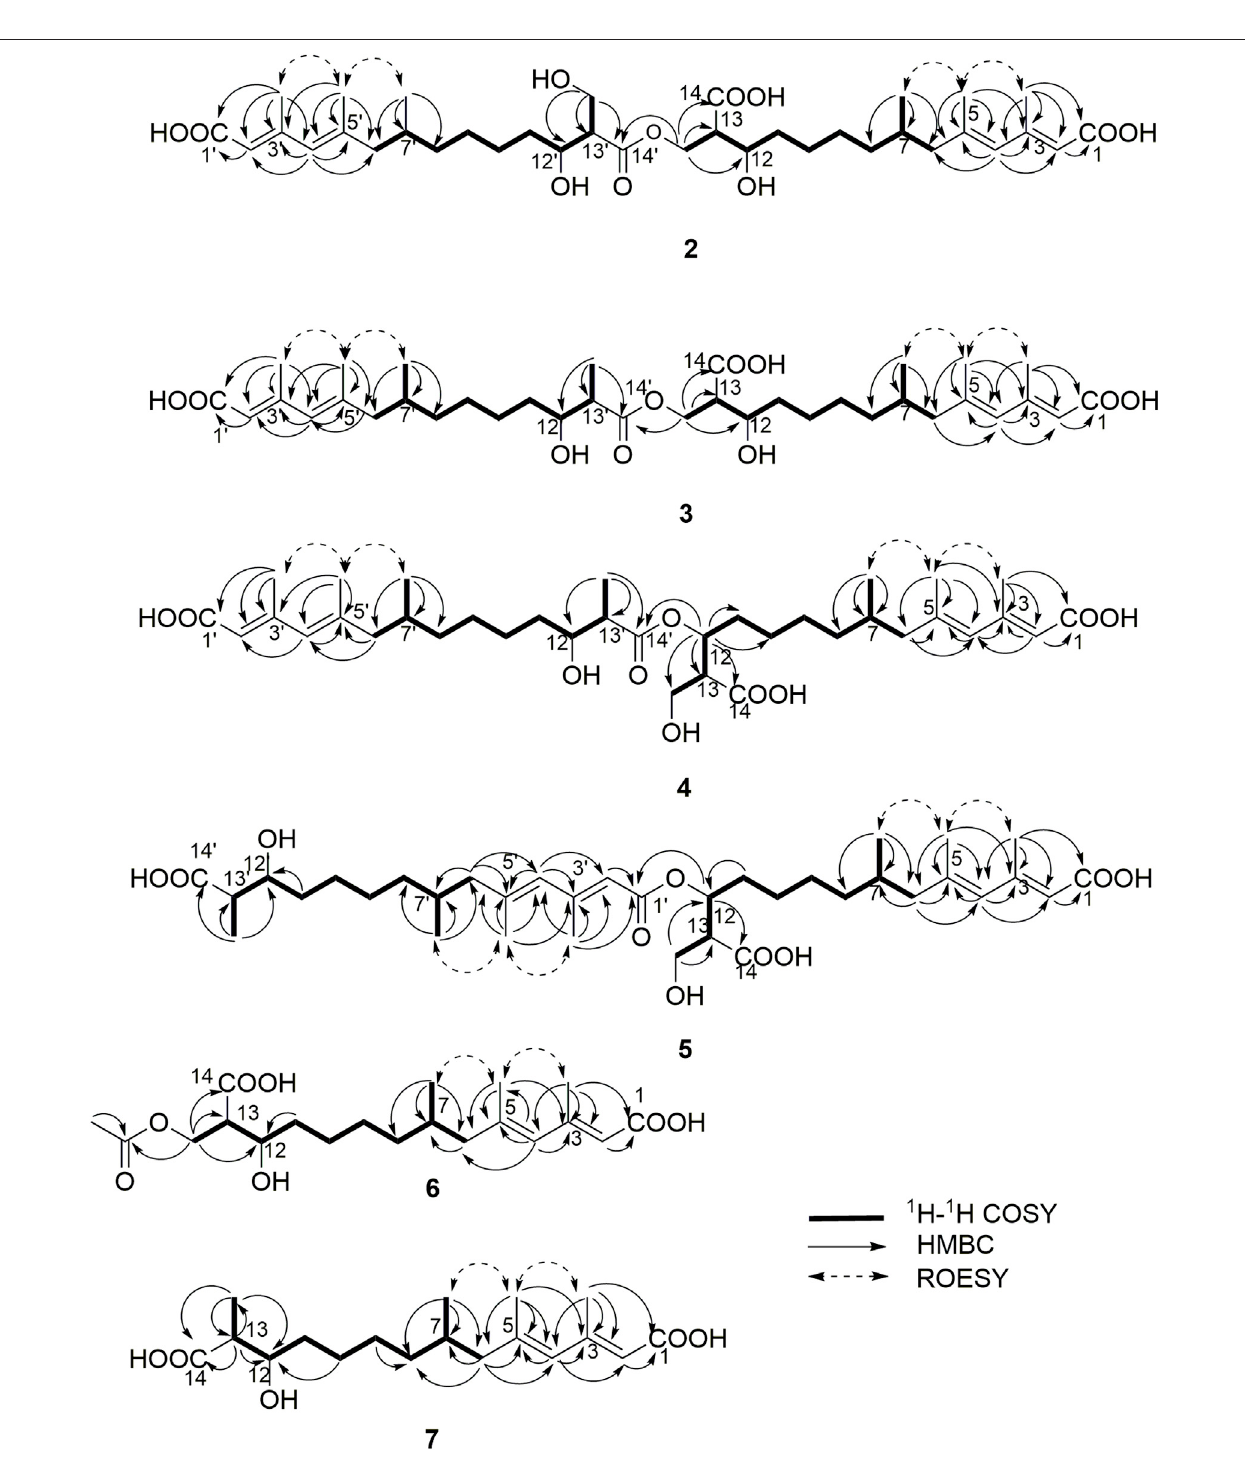
FIGURE 2 | Key HMBC, 1 H – 1 H COSY and ROESY correlations of compounds 2 ‒ 7 .